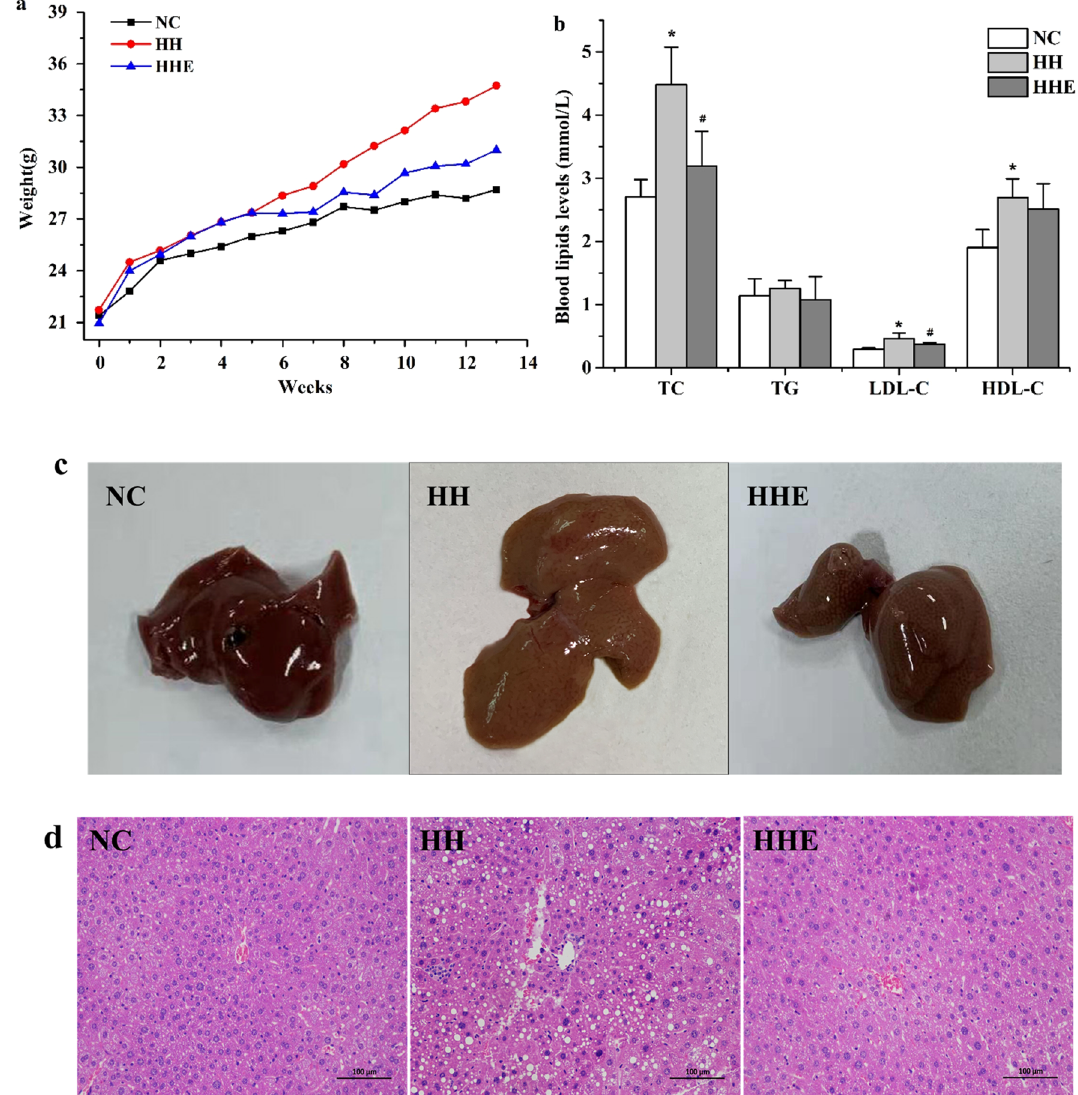
( d ) HE staining to observe liver steatosis grade. *P < 0.05 VS NC group, # P < 0.05 VS HH